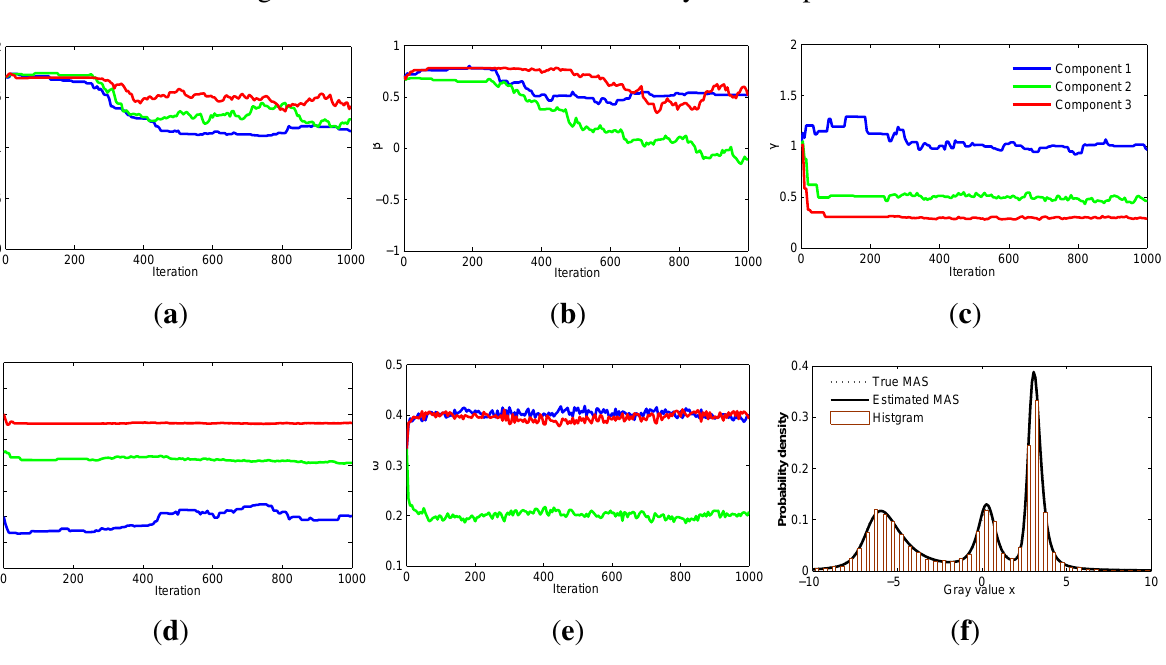
Figure 2. Simulation results for the PSA estimator. ( a )–( e ) Evolution procedure of the three components for parameters α , β , γ , µ and ω , respectively (red: component 1, green: component 2, blue: component 3); ( f ) Fitting results of the estimated MAS distributions to simulated data histogram and the PDF curve obtained by the true